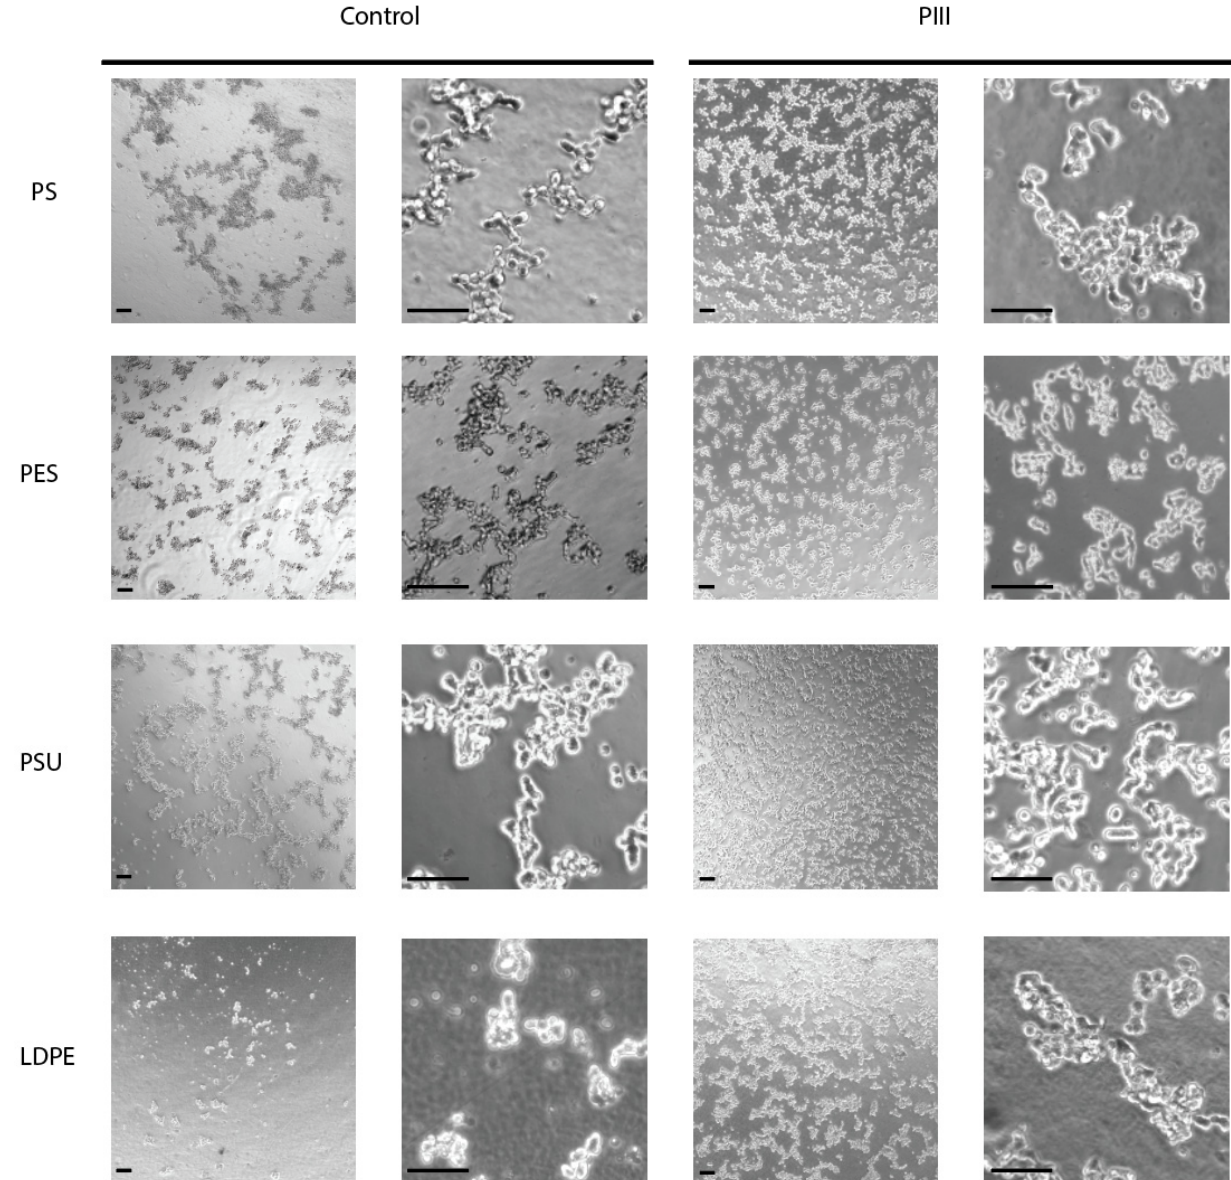
Figure 8. MIN6 cells were seeded on PIII-treated and untreated polymers coated with laminin. Brightfield images were taken on a fluorescent desktop microscope at 20× and 40× magnification. Scale bar represents 50 µm.